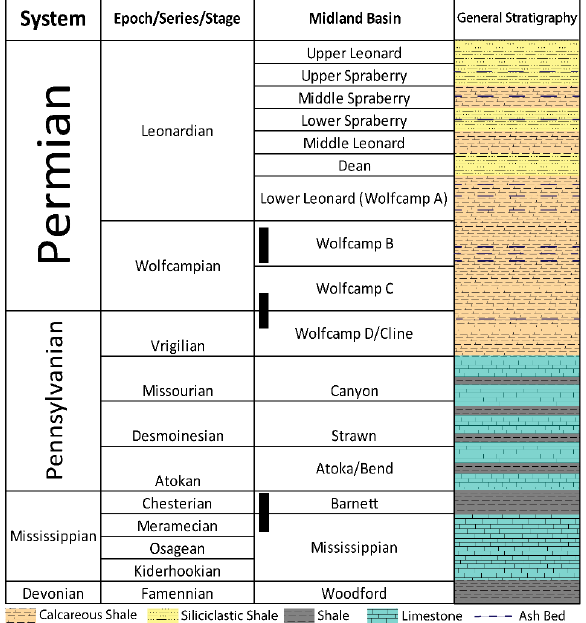
Figure 2. Stratigraphic nomenclature used within the Midland Basin. Core intervals are noted by the black columns. General lithologies and stratigraphy are modified after Ewing (2016) [54] and Hamlin and Baumgardner, (2012) [65]. Ash bed intervals are modified after Leslie et al. (2019) [70]. Geosciences 2020 , 10 , x FOR PEER REVIEW